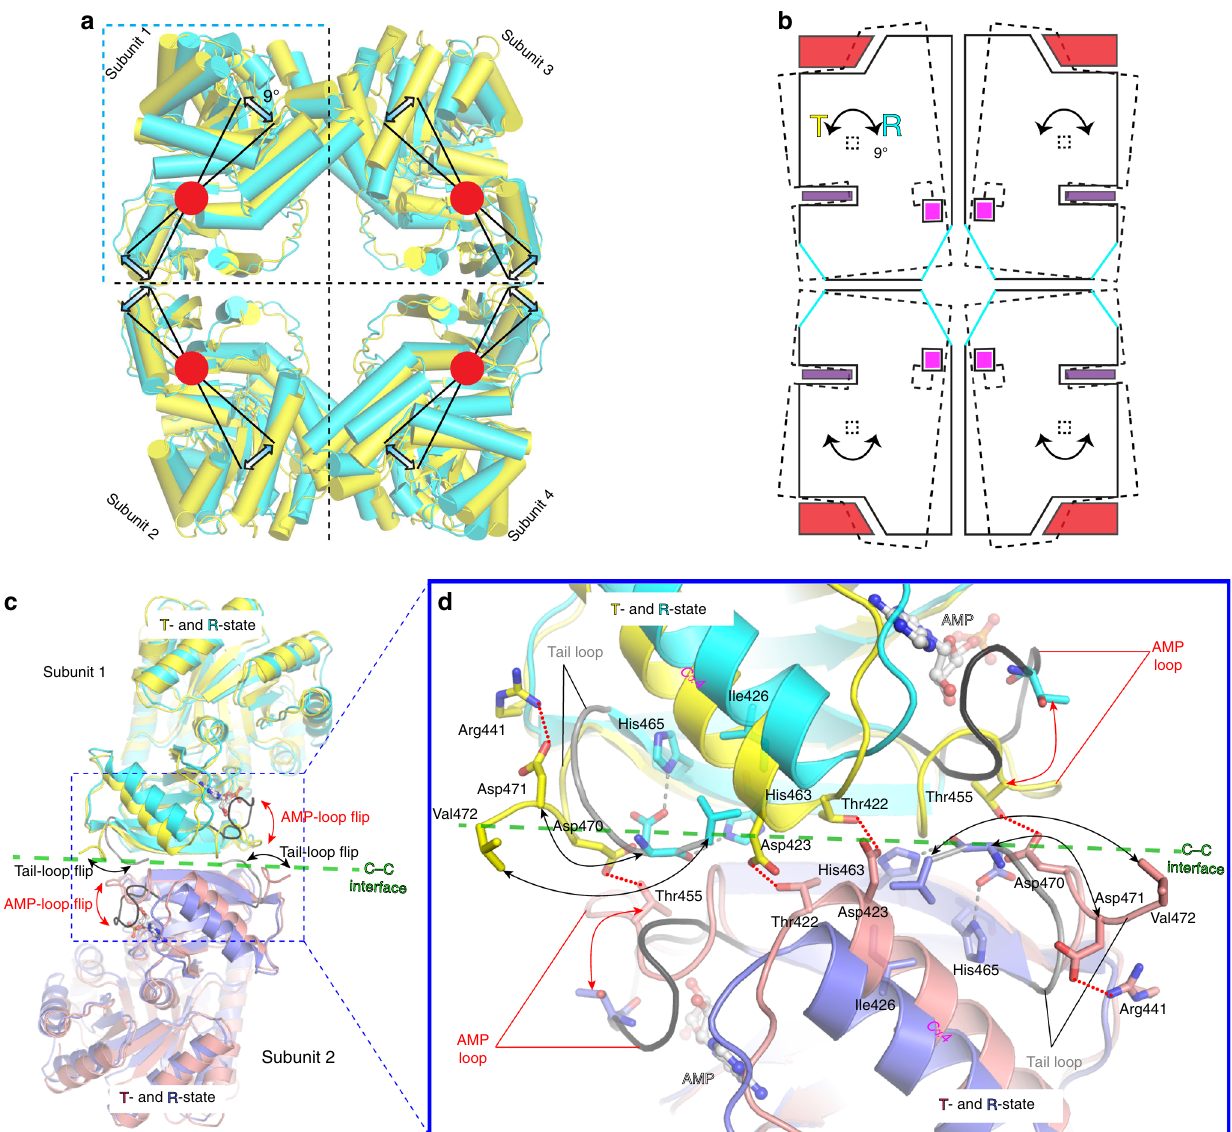
Fig. 2 T- to R-state transition requires the disruption of C – C interface interactions and is enhanced by effector binding. a Rigid-body rotation showing the transition between T- and R-states of Mtb PYK. The C- α atoms of the AC cores (A- and C domains) of the inactive T-state tetramer (yellow) were superposed onto the active R-state tetramer (cyan). The superposed polypeptide chains are shown as cartoons, and B-domains have been removed for clarity. The T- (yellow) and R-state (cyan) transition is represented by a 9° rigid-body (AC core) rotation around the central pivot (indicated by the red circle). b Schematic representation of the rigid-body rotation of the AC cores between the T- (dashed lines) and R-states (solid lines). Ligands AMP, G6P and oxalate are shown as purple rectangle, magenta square and red trapezoid, respectively. The direction of movement is shown using arrows. The structural reshaping of the allosteric sites induced by AMP/G6P synergism is indicated in cyan. c Side view of the superposed tetramers of T-state Mtb PYK and R-state Mtb PYK-OX/AMP/G6P. The AC cores of two tetramers were superposed (C- α atoms fi t). The polypeptide chain is shown as a cartoon while effectors are shown as sticks. The B domains have been removed for clarity. Only two subunits are shown: subunit 1 and subunit 2. The C-C interface formed between subunit 1 (T-state in yellow and R-state in cyan) and subunit 2 (T-state in salmon and R-state in blue) is indicated using a green dashed line. Interface loops are indicated and the fl ips of loops between T- and R-states are shown by arrows. In the R-state, AMP loops and tail loops are indicated in black and grey, respectively. d Enlargement of the C – C interface indicating the conformational changes and the rearrangement of interface interactions. The movements of loops and residues are indicated by arrows. Interactions in the T-state structure are shown as red dotted lines, while interactions in the R-state structure are shown as grey dashed